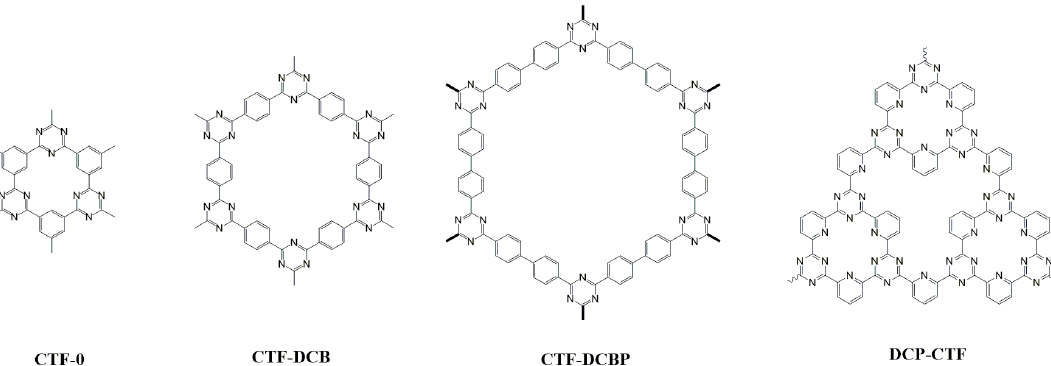
Figure 4. Structure of triazine ‐ containing COFs reviewed.